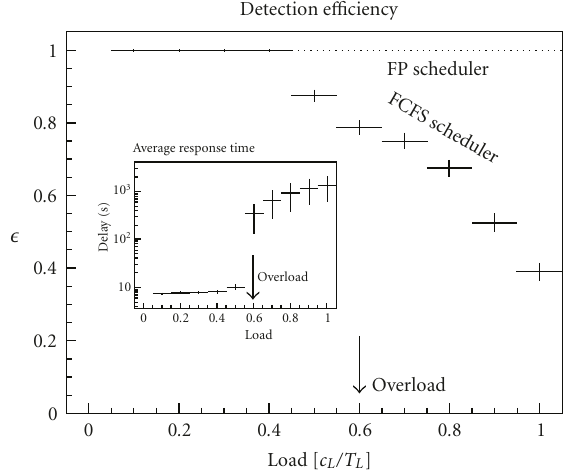
Figure 29: E ffi ciency as a function of CPU load factor in device nodes for Fixed Priority (FP) and First Come First Served (FCFS). The embedded frame contains the distribution of the Average Response Time in semi-log scale for FCFS. Overload condition occurs when c L /T L = 60% > 50%.